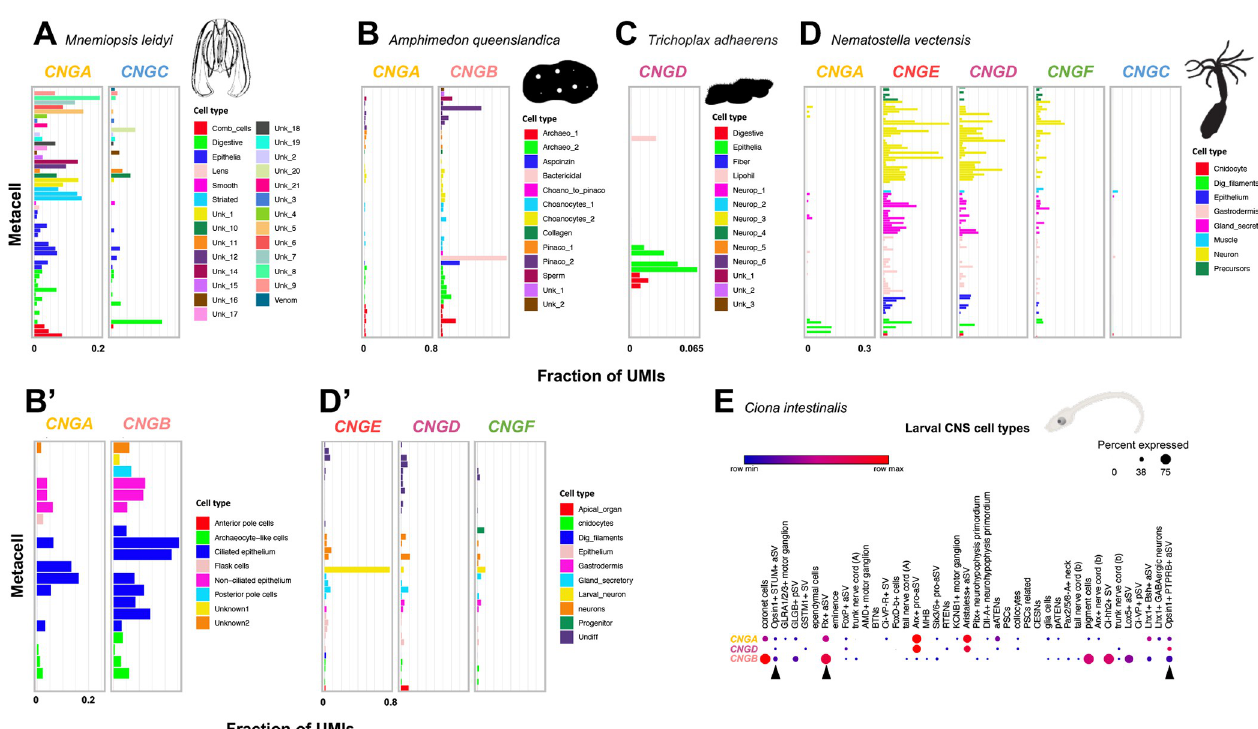
Fig 7. Expression of CNG genes in non-bilaterian metazoans and in the tunicate Ciona intestinalis . A) Expression of CNGA and CNGC in ctenophore metacells shows differential expression across cell types. B) Expression of CNGA and CNGB in sponge adult metacells show, like in the ctenophore, differential expression of both genes. B’) Co-expression of both genes in the larval sponge. C) Expression of the single CNGD gene in the placozoan metacells. D) Expression of the five CNG genes in the adult cnidarian Nematostella vectensis show overlap in expression in the same metacells for CNGE , CNGD and CNGF , while CNGA and CNGC have lower expression. CNGA has its highest expression in digestive filament metacells. D’) In the larval Nematostella vectensis only CNGE , CNGD and CNGF are expressed and CNGE has the highest expression in larval neurons. E) Expression of the identified CNG genes in the Ciona intestinalis larval central nervous system show both overlapping expression of CNGA and CNGB , and CNGA and CNGD as well as expression of only CNGB in some cells. Black arrows represent photoreceptor cells in the anterior sensory vesicle or their precursors. Silhouettes were retrieved from phylopic.org and are all dedicated to the public domain. Illustration of Ciona intestinalis larva was kindly provided by Dr. Daniel Ocampo